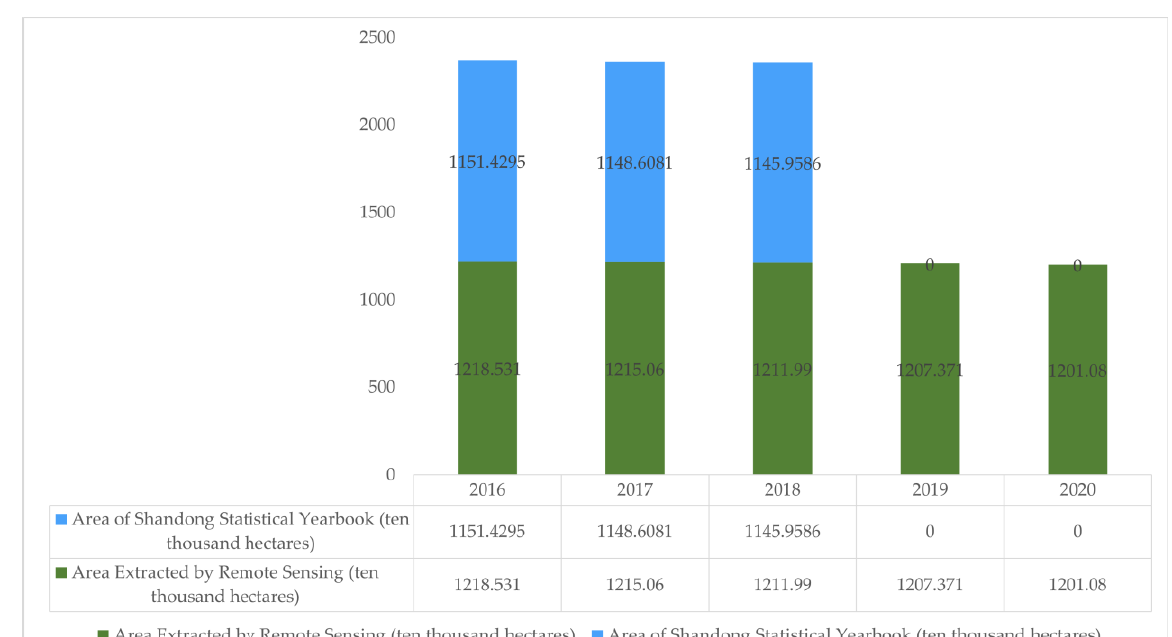
Figure 11. Classification and extraction of agricultural land area and Shandong official statistical yearbook agricultural land area comparison.